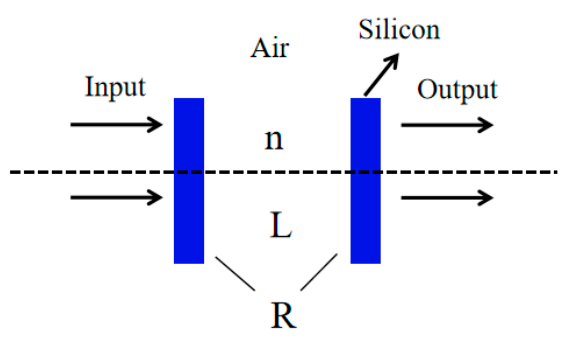
Figure 3. The Schematic diagram of F–P etalon.